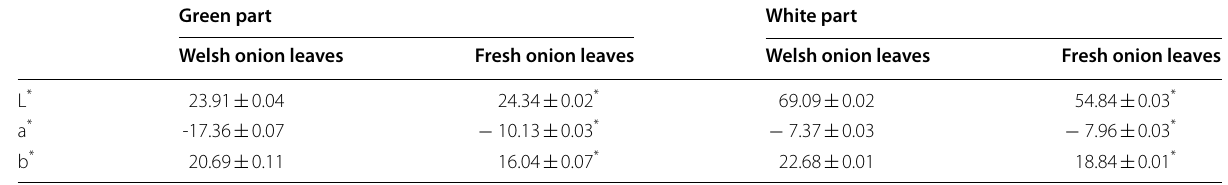
Values are the mean SD ( n 15). * p < 0.05 (Welch’s t test), compared between Welsh onion and flesh onion leaves in each value ± =